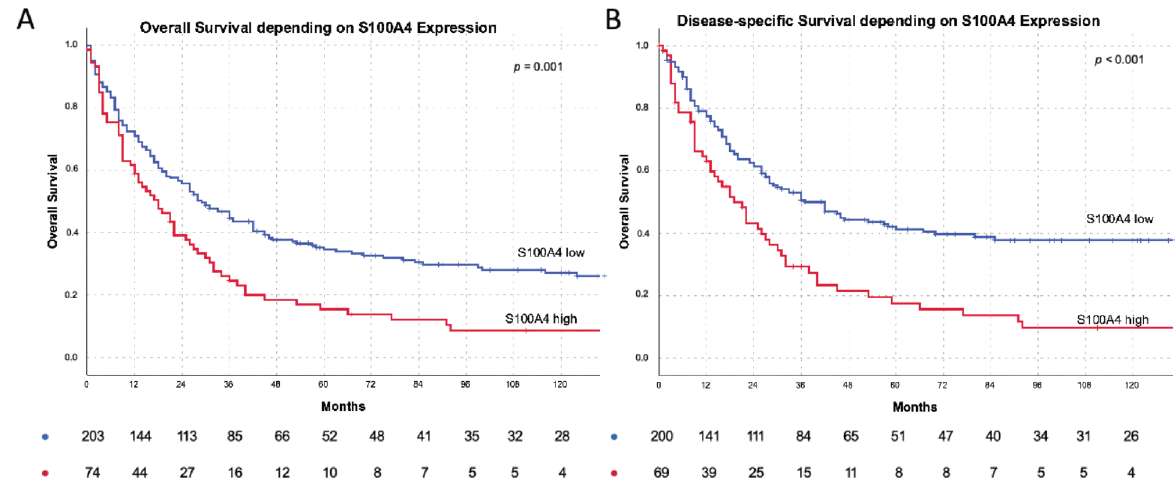
Figure 2. S100A4 survival and subgroup survival analysis: ( A ) S100A4 depending overall survival: n = 203 S100A4 low (blue): 66 months vs. n = 73 S100A4 high (red): 35 months mean survival ( p = 0.001). ( B ) S100A4 depending disease specific survival: n = 200 S100A4 low (blue): 83.6 months vs. n = 69 S100A4 high (red) 38.4 months mean survival ( p < 0.001). Tables below the Kaplan – Meyer